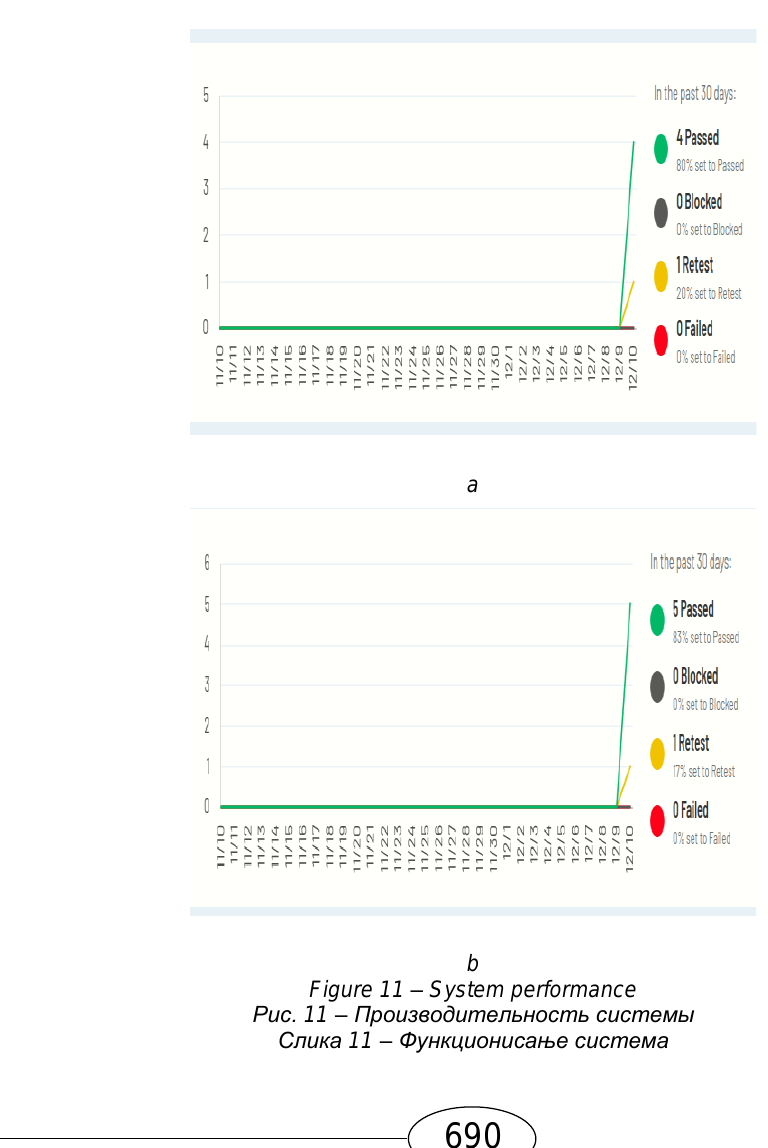
Figure 11 – System performance Рис. 11 – Производительность системы Слика 11 – Функционисање